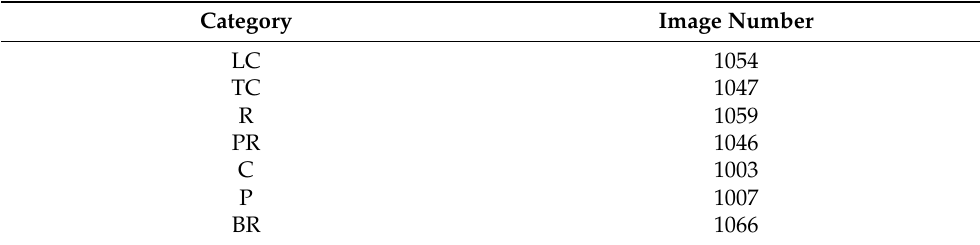
Table 1. The number of images per category in